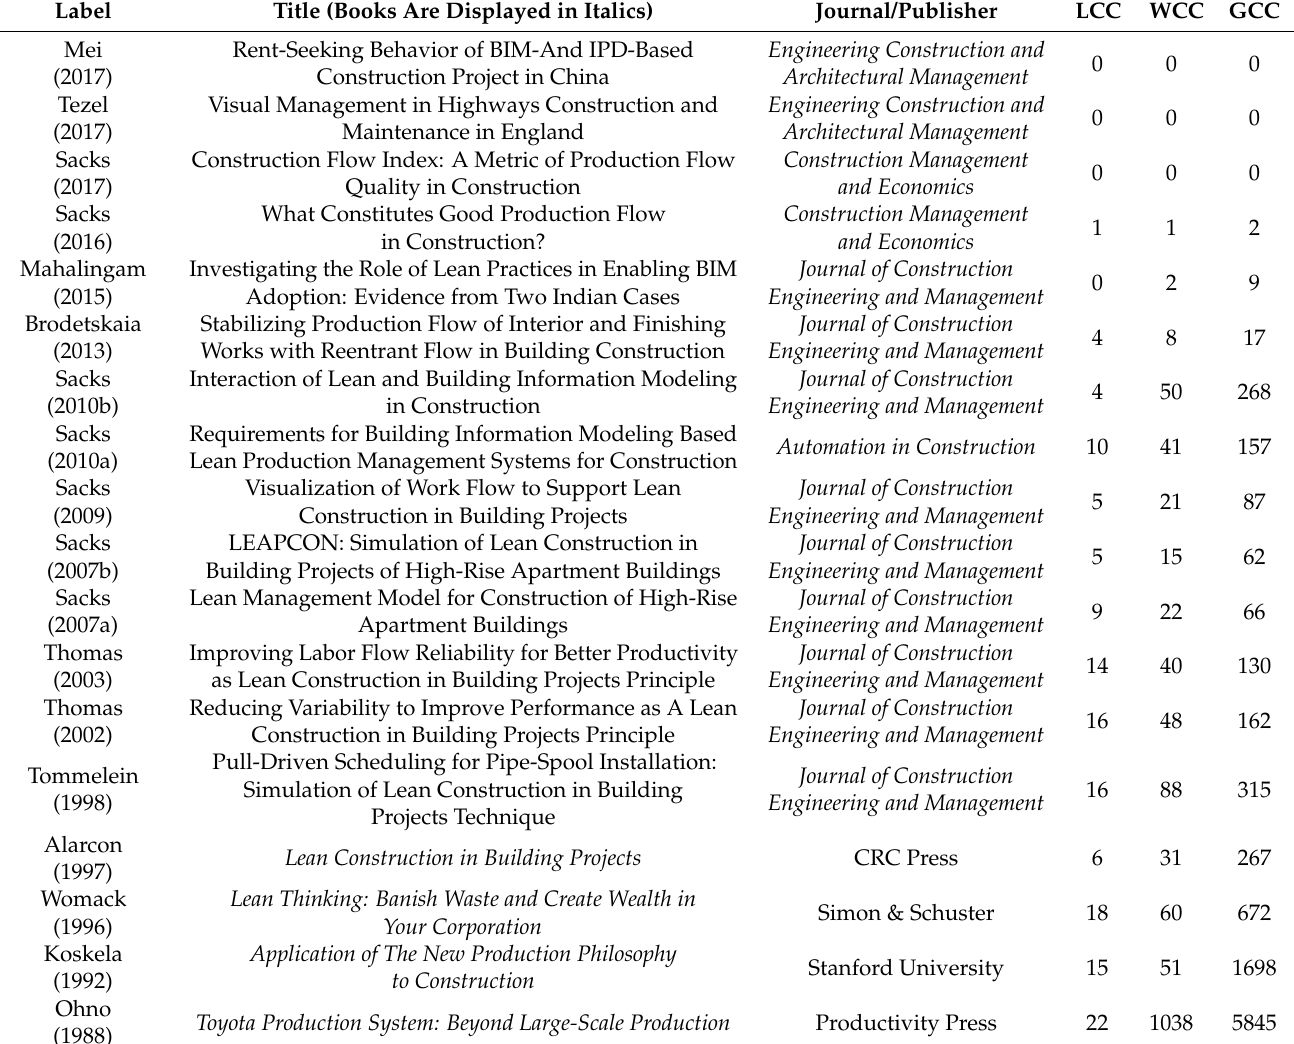
Table A1. Publications in the main path of Lean Construction in Building